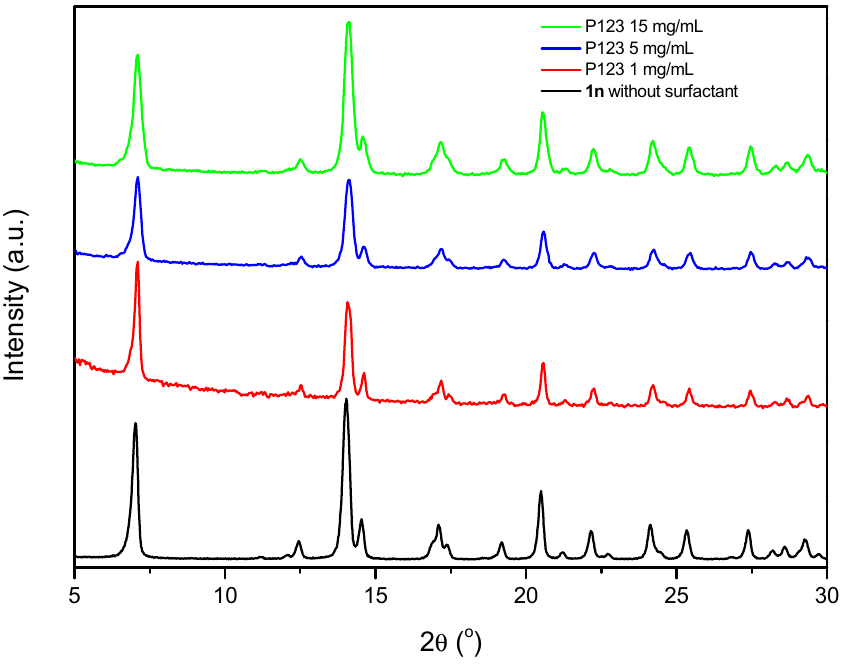
Figure 9. X-ray powder diffraction patterns of {[Cu 2 ( µ 3 -adeninato) 2 ( µ -Hadip) 2 ]} n ( 1n ) (black) and the obtained products under different concentrations of the P 123 surfactant.